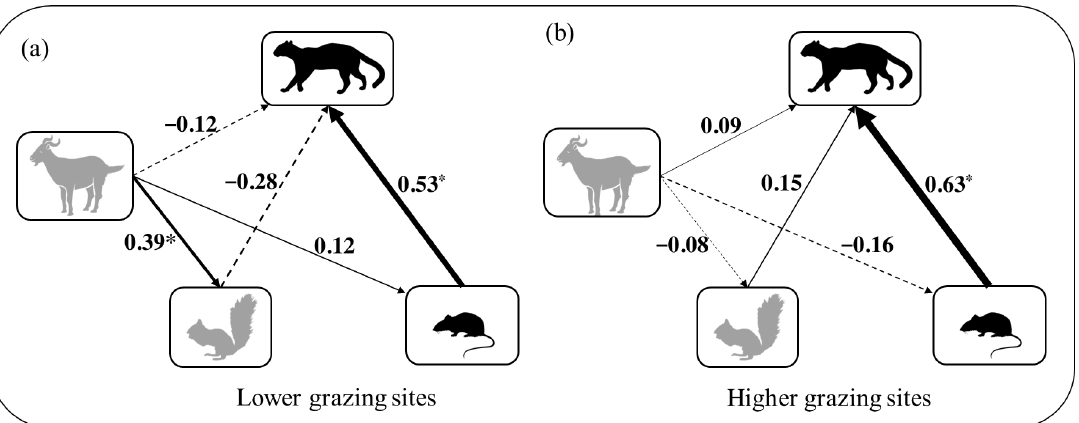
Figure 5. Net effects of standardized path coefficients of the SEM for leopard cats, their prey, and livestock in the higher ( a ) and lower grazing sites ( b ), respectively. Dashed arrows indicate negative effects; solid arrows represent positive effects. The numbers alongside the arrows are the standardized path coefficients. Paths with p < 0.05 are labeled with asterisk (*), and the line width is proportional to the size of the effect.